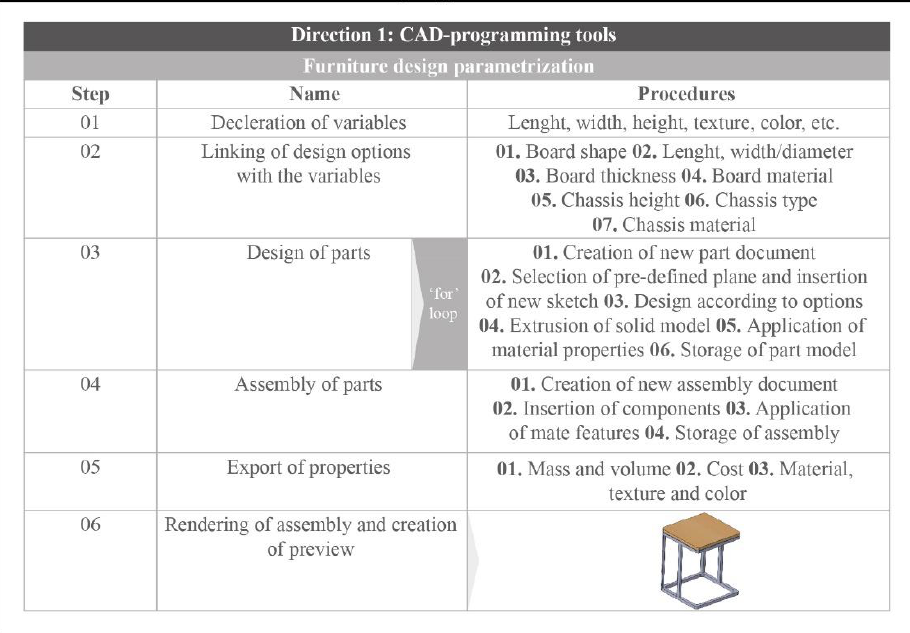
Figure 3. Workflow of the coffee table design application.